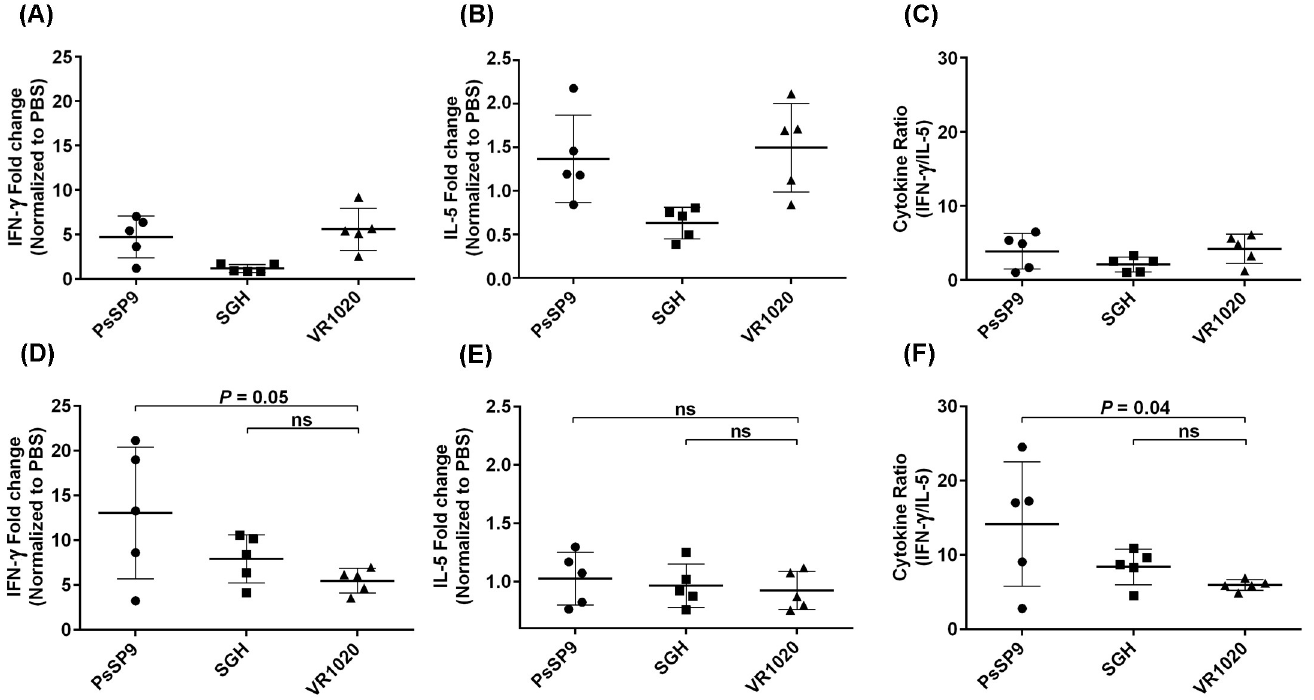
Fig 6. Cytokine expression profile in the dLN of PsSP9 -immunized mice a-t one and two months after L . tropica plus Ph . sergenti SGH challenge. BALB/c mice (ten mice per group) were immunized in the right ear three times at two-week intervals with Ph . sergenti SGH, plasmid coding for PsSP9, empty plasmid (VR1020) or PBS. Two weeks after the last immunization, mice were challenged with 10 7 metacyclic L . tropica plus Ph . sergenti SGH in the contralateral ear. Data shown are from one representative of two independent experiments. (A) IFN- γ , (B) IL-5 and (C) the ratio of IFN- γ to IL-5 expression in the dLN of BAB/c mice (four to five mice per group) immunized with PsSP9, Ph . sergenti SGH, VR1020 or PBS, at one month post-challenge with L . tropica plus Ph . sergenti SGH. The obtained results were normalized to the expression level of HPRT. These data are presented as fold change relative to the PBS control group. (D) IFN- γ , (E) IL-5 and (F) the ratio of IFN- γ to IL-5 mRNA expression in dLN of BALB/c mice (five mice per group) immunized with PsSP9, Ph . sergenti SGH, VR1020 or PBS, at two months post challenge with L . tropica plus Ph . sergenti SGH. The obtained results were normalized to the expression level of HPRT. These data are presented as fold change relative to the PBS control. The p value is indicated for each vaccinated group compared with the control plasmid group (VR1020).